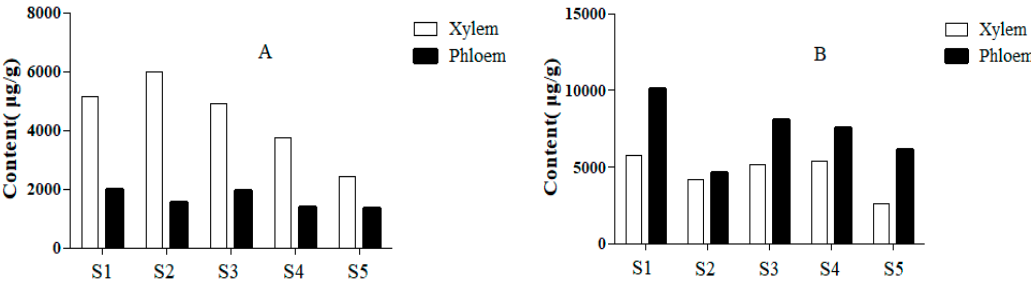
Figure 2. The content difference of 22 compounds by heat map. Figure 3. Contents of flavonoids ( A ) and protocatechuic acid ( B ) in xylem and phloem of SC.